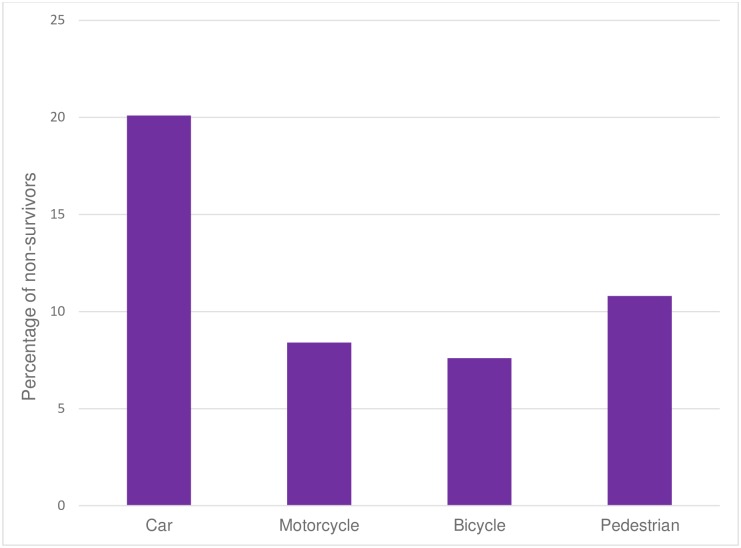
Percentage of traffic accident modalities as leading cause of fatal trauma.